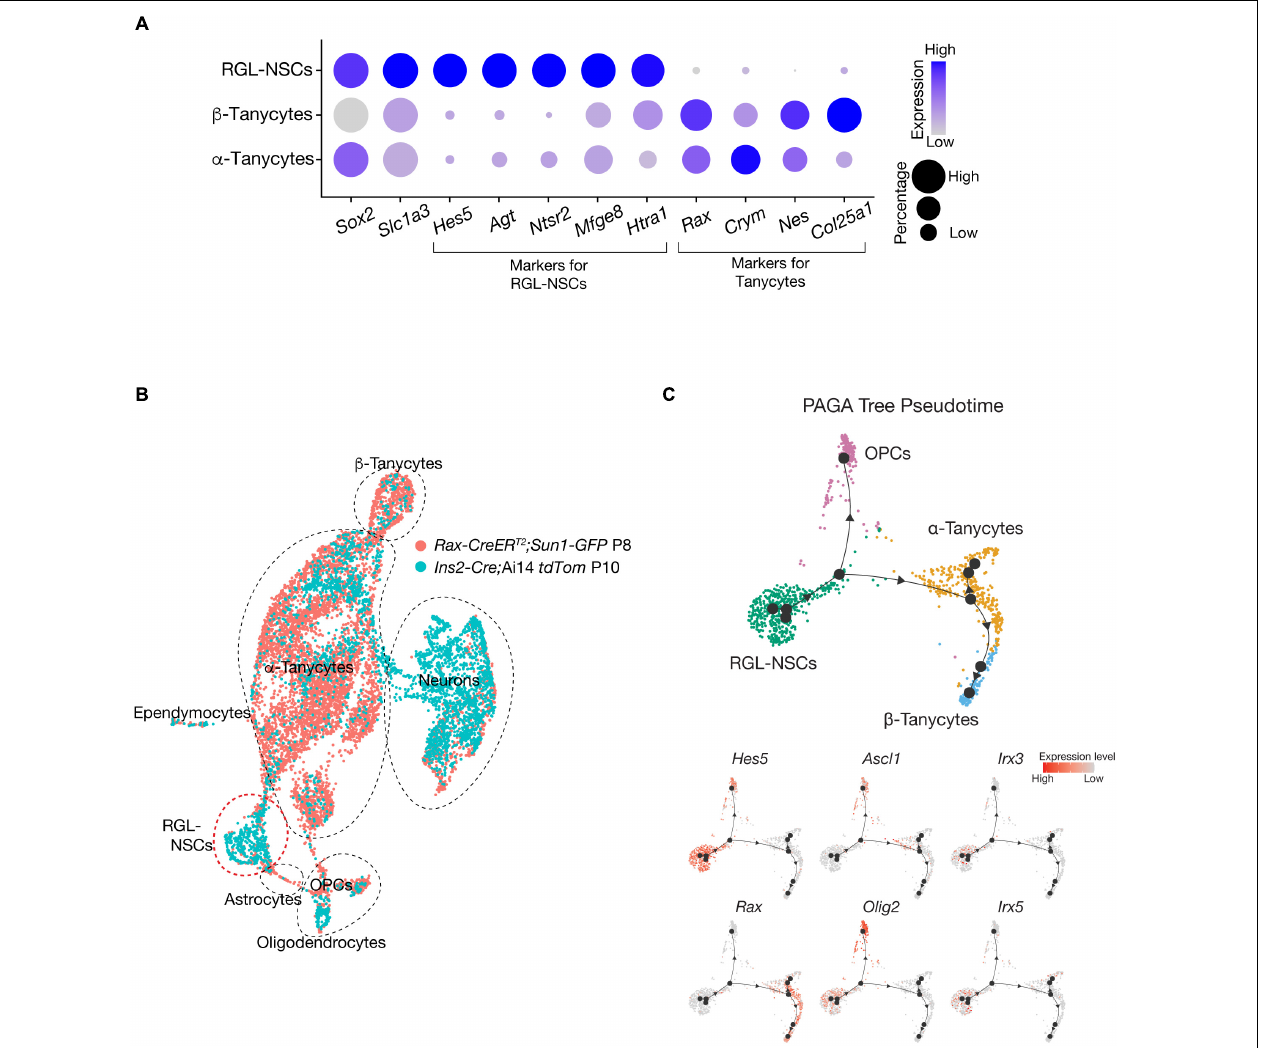
FIGURE 4 | Irx3 and Irx5 expressing RGL-NSCs are distinct from tanycytes. (A) Expression of cell type-specific markers in RGL-NSCs, α -tanycytes, and β -tanycytes from the Ins2-Cre ;Ai14 tdTomato scRNA-seq dataset. The size of the dot indicates the percentage of cells expressing a specific gene in each cluster, and the color represents the average expression level of the gene. RGL-NSCs and tanycytes share expression of the broad stemness marker Sox2 and glial marker Slc1a3 (also known as GLAST), while NSCs markers such as Hes5 , Agt , Ntsr2 are almost exclusively found in RGL-NSCs, and canonical tanycytes markers such as Rax and Crym are absent in RGL-NSCs. (B) Integrated UMAP plot of Rax-CreER T 2 ; Sun1-GFP at P8 ( Cre recombinase activity induced between P3 and P5) (GSE160378) and Ins2-Cre ;Ai14 tdTomato at P10 (GSE154969) scRNA-seq datasets through the reference-based integration feature of Seurat and UMAP visualization. The RGL-NSC cluster consists of cells originating from the Ins2-Cre ;Ai14 tdTomato dataset, and does not overlap with tanycytes nor astrocytes. Also note that while a much larger amount of tanycytes are detected in the Rax-CreER T 2 ; Sun1-GFP dataset, Ins2-Cre ;Ai14 tdTomato is more robust at labeling neurons. (C) Pseudo-temporal analysis of Ins2-Cre labeled RGL-NSCs, tanycytes and OPCs using Partition-based graph abstraction (PAGA) Tree. The line with arrowhead indicates the inferred differentiation trajectory, which originates from Hes5 -expressing RGL-NSCs, undergoes a bifurcated differentiation path to Olig2 -expressing OPCs and Rax -expressing tanycytes. The NSC activation marker Ascl1 is detected in bridge cells but not in RGL-NSCs, suggesting their